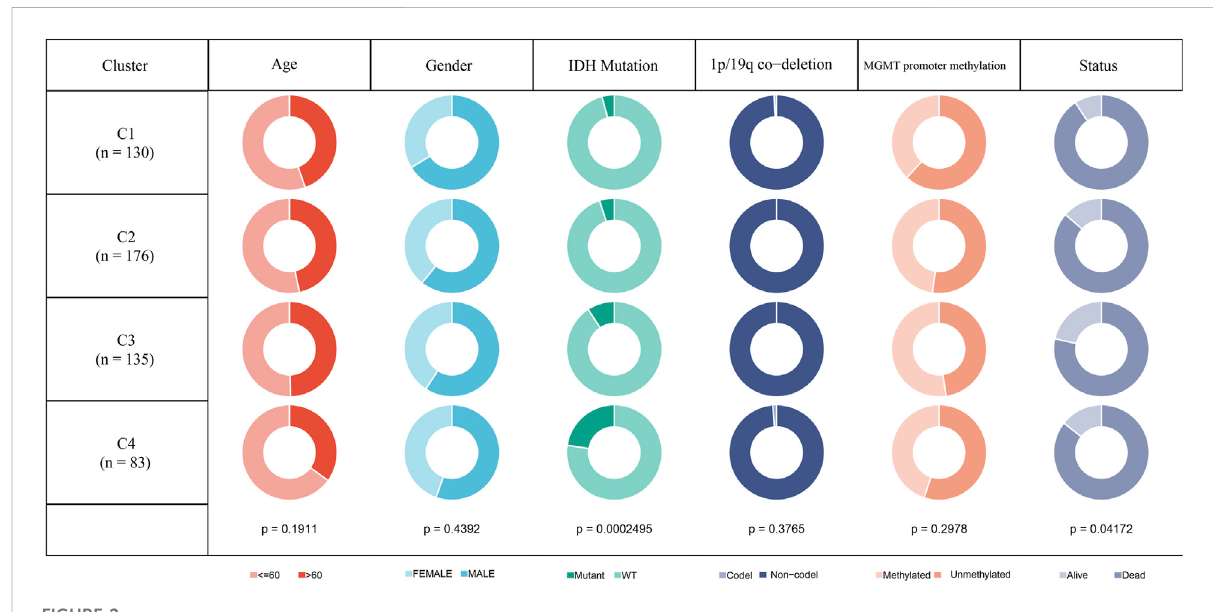
FIGURE 2 Clinicopathological features of molecular subtypes in TCGA-GBM